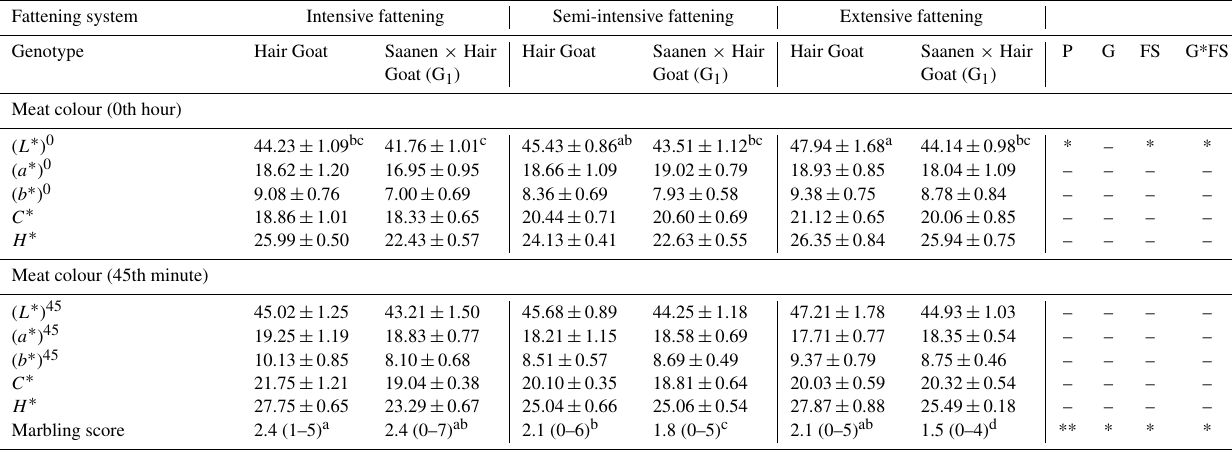
Table 3. Meat colour parameters of Hair Goat and Saanen × Hair Goat (G 1 ) crossbred kids.